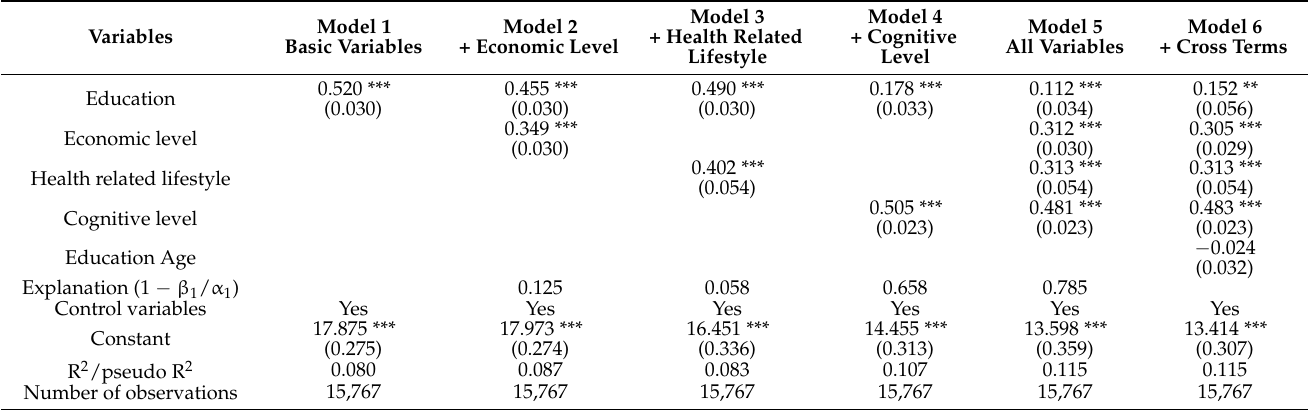
Table 3. Results of multiple regression analysis and mediation effect analysis of all samples.